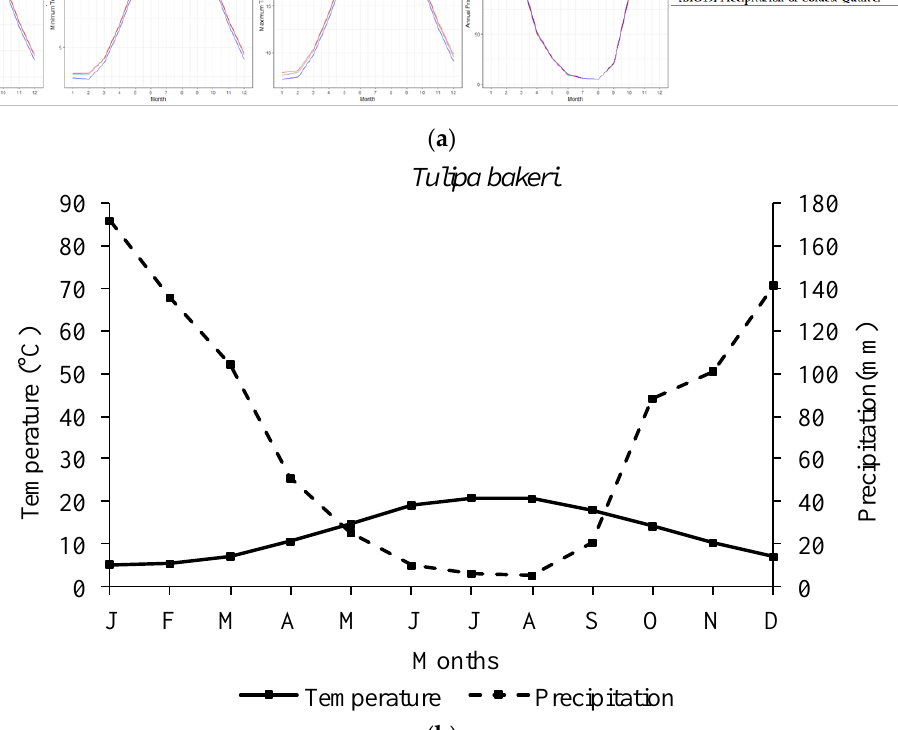
Figure 3. R-derived ecological profile ( a ) and Walter–Lieth climate diagram ( b ) of Tulipa bakeri based on nine localities known to date (N = 9). For ( A – E ), minimum, maximum, and average values and standard deviations are represented in different columns. Line graphs ( A – C ) illustrate the minimum (blue), the maximum (red), and the mean (grey) monthly temperature ( ◦ C) and the line graph ( D ) illustrates the minimum (red), maximum (blue), and mean (grey) monthly precipitation (mm). ( A ) shows the minimum temperature in each month ( ◦ C), ( B ) shows the maximum temperature in each month ( ◦ C), ( C ) shows the average temperatures per month ( ◦ C), ( D ) shows the precipitation in each month (mm), and ( E ) shows the values for each of the 19 bioclimatic